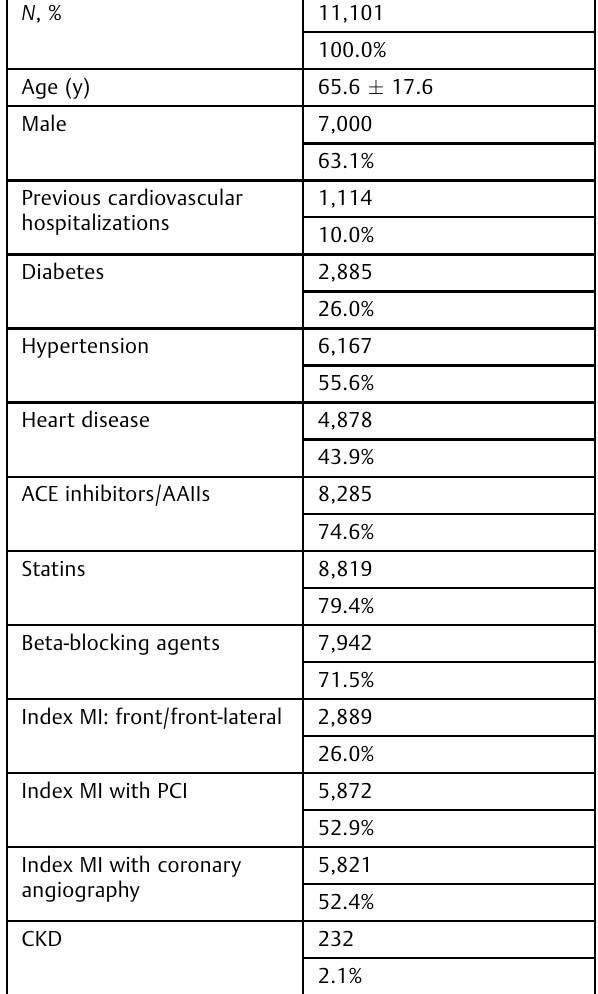
Table 1 Demographic and clinical characteristics of included patients